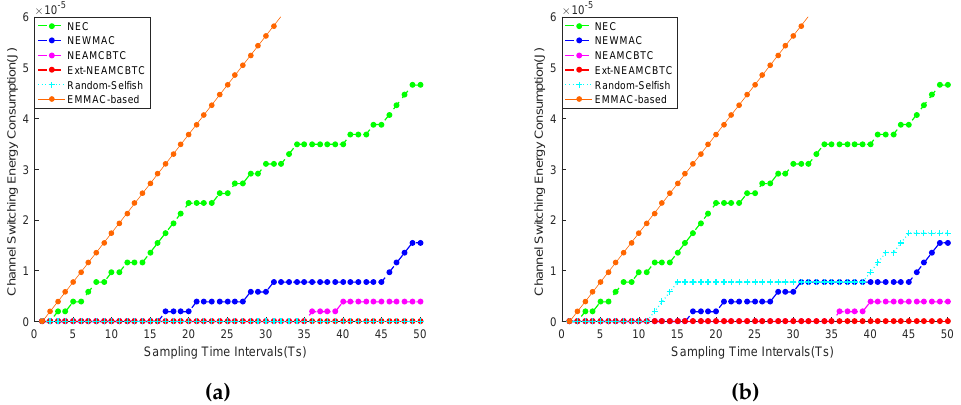
Figure 9. Channel switching energy overhead. ( a ) Case I: the channel switching energy consumption of the compared techniques shows that Ext-NEAMCBTC and random selfish (in the above scenario) are the best due to no switching energy overhead, while the EM-MAC-based approach behaves the worst among all. ( b ) Case II: the channel switching energy consumption of the compared techniques shows that Ext-NEAMCBTC is superior while random selfish (in the above scenario) performs worse than the NEWMAC approach. Random channel selection gives varying behavior to the random selfish